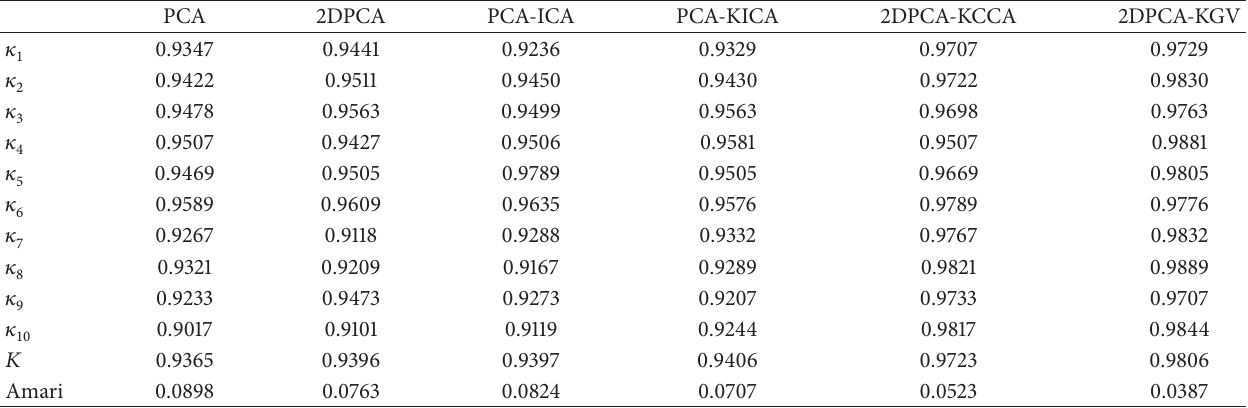
Table 1: Different dimension reduction results of dimensional reduction methods for multidimensional feature samples.